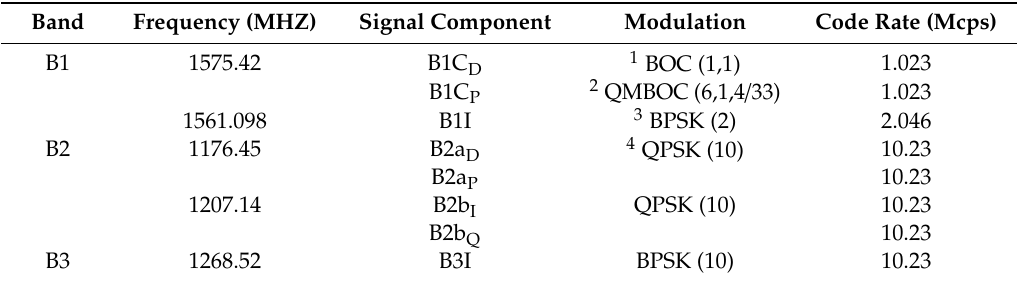
Table 2. Available open service signals transmitted by BDS-3 operational satellites [1,4,6].